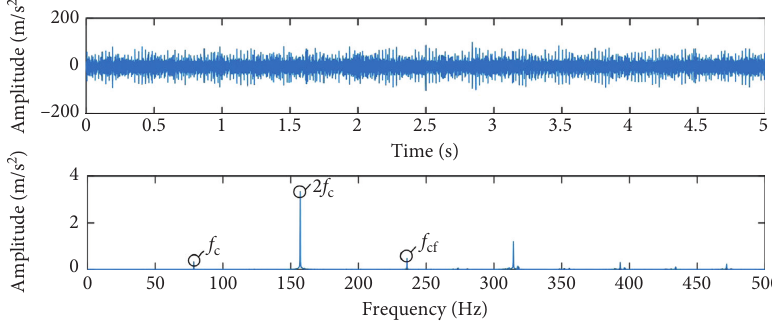
Figure 26: Original vibration